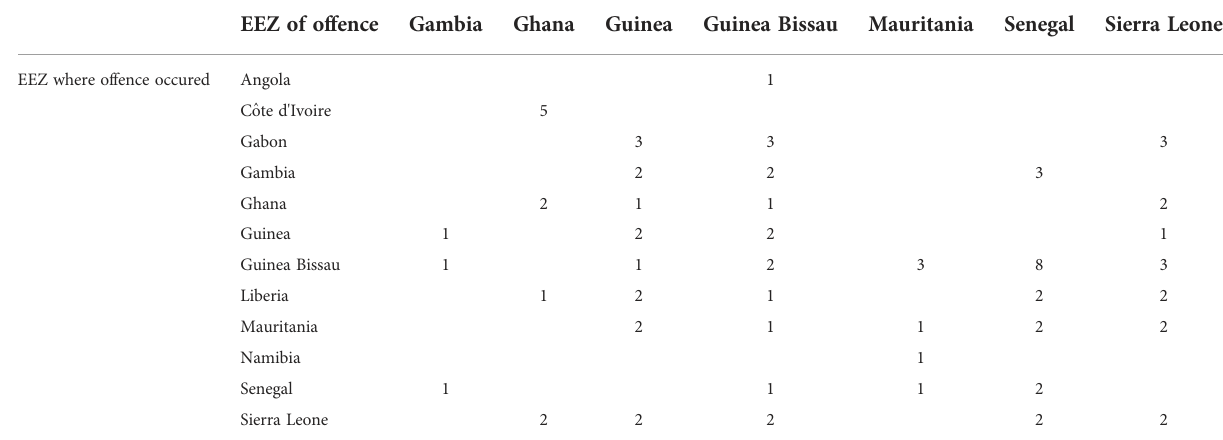
Values represent the average number of incidents reported for individual vessels between 2010 and 2019, based on the average number of times a vessel licensed to fi sh in a coastal state of West Africa (top row) appeared as incidents on the CRFV in the neighboring country (column). Licenses are assessed for Gambia, Ghana, Guinea, Mauritania, Senegal, and Sierra